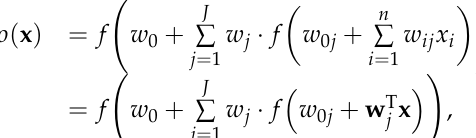
Figure 3. Flowchart for three-level MODWT.